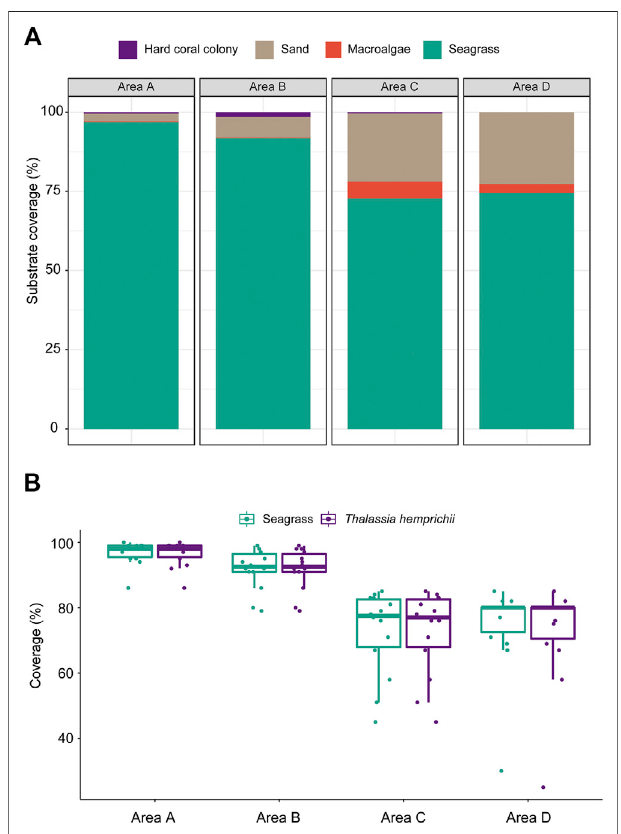
FIGURE 5 | (A) The average substrate coverages (%) and (B) variations in seagrass coverage and T. hemprichii coverage of 10-m line transects (N = 14) in the four survey areas A − D at West